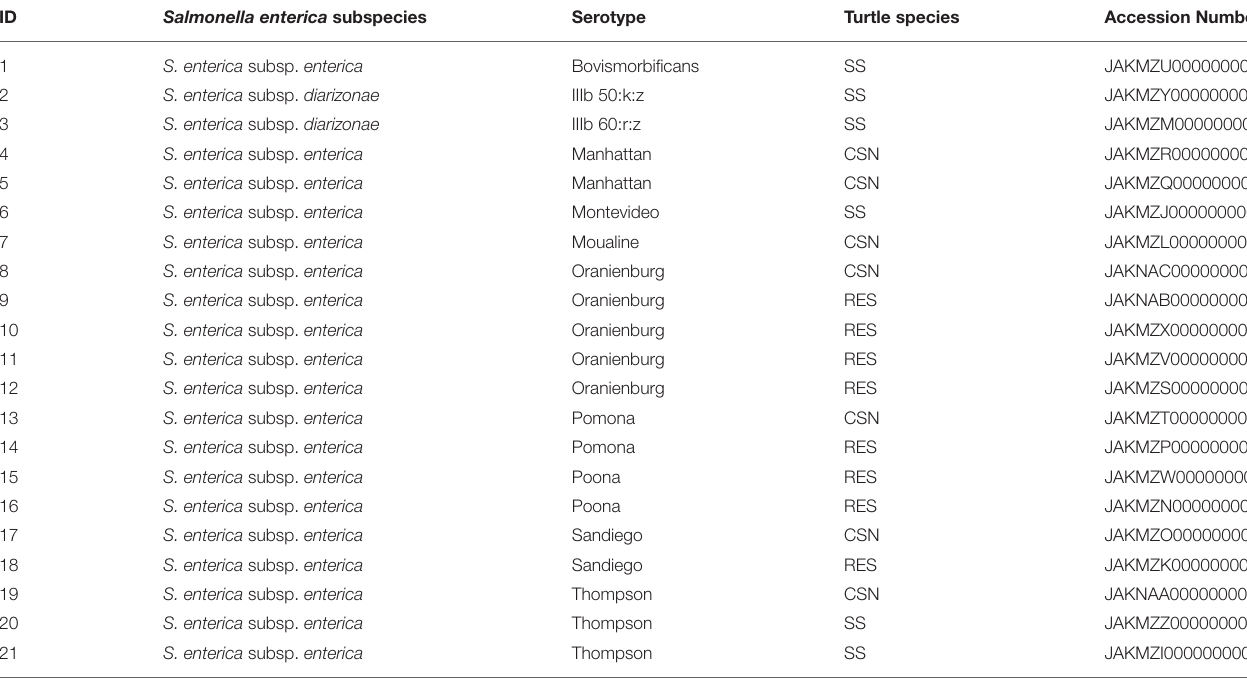
TABLE 2 | Serotypes, turtle species of origin and GenBank accession numbers of Salmonella enterica isolates.